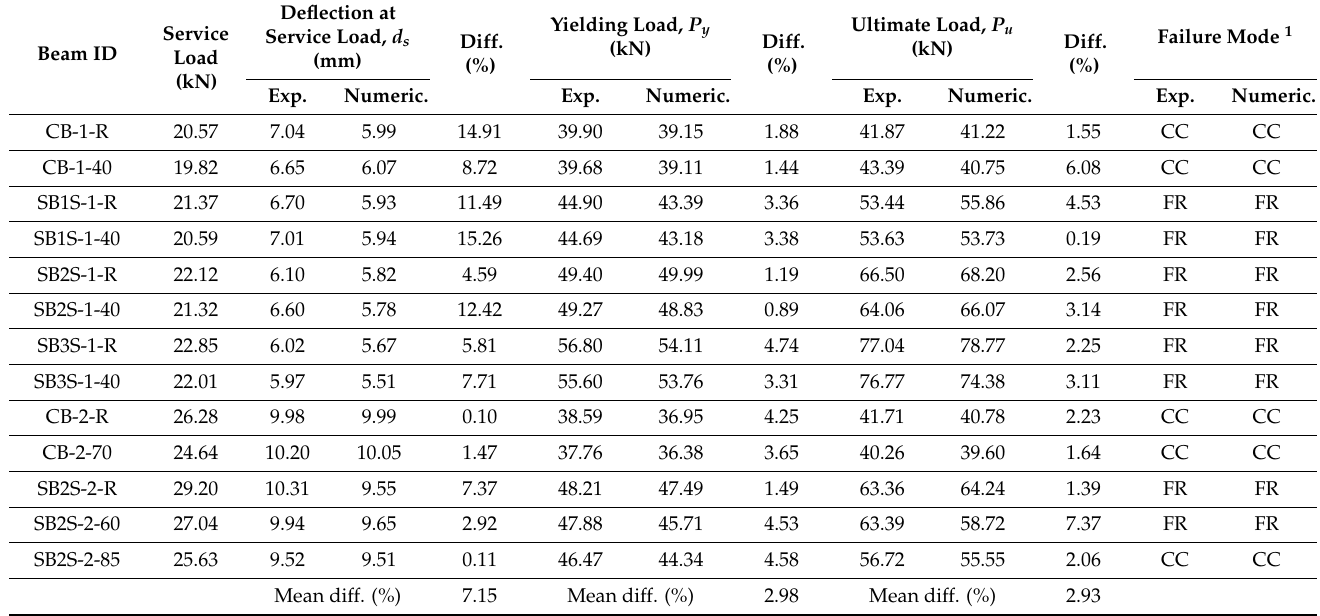
Table 4. Comparison between numerical predictions and experimental